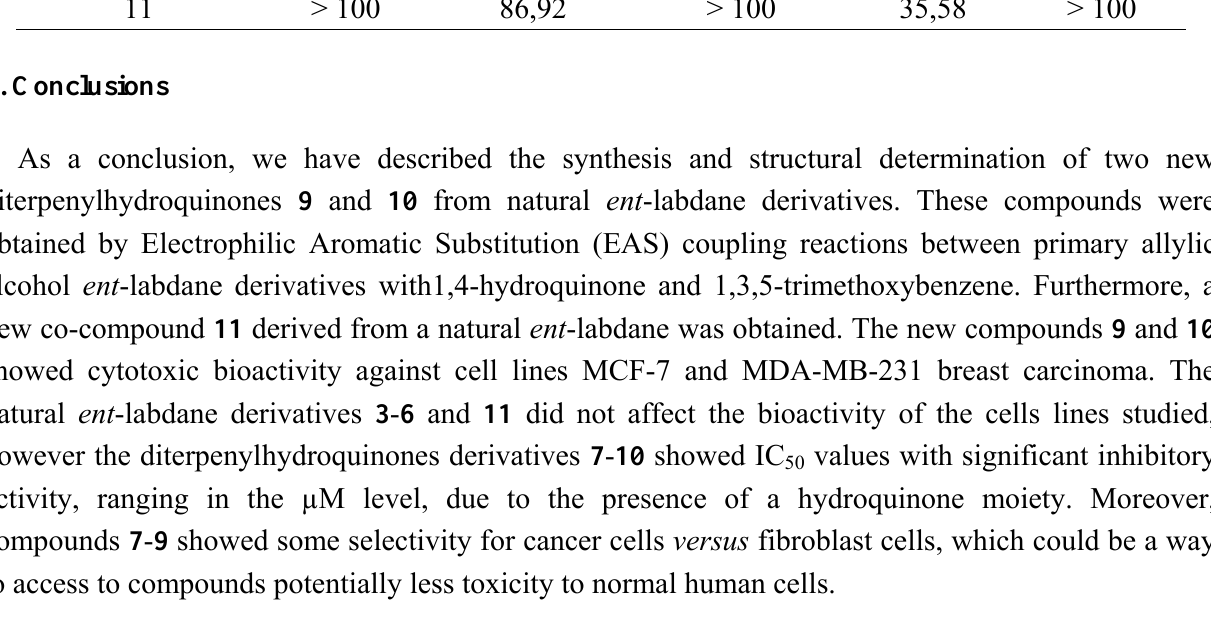
Table 1. Cytotoxicity (IC